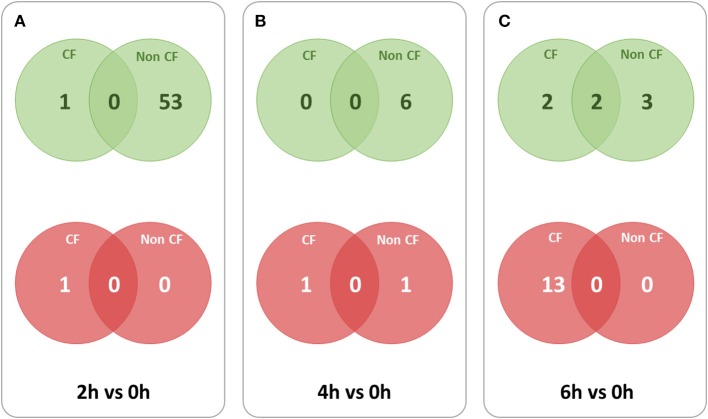
Overlaps between lncRNA transcripts differentially expressed at different time points in CF and non-CF datasets. Red circles represent down-regulated transcripts and green circles represent up-regulated transcripts. (A) 2 h in comparison with 0 h time point, (B) 4 h in comparison with 0 h time point, (C) 6 h in comparison with 0 h time point.